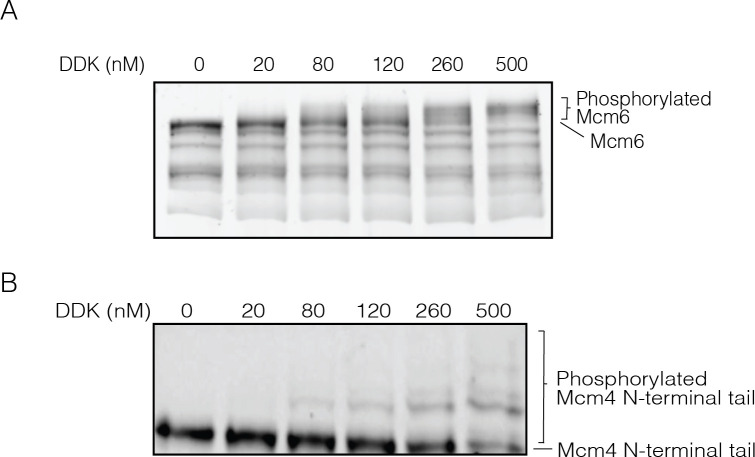
Higher Dbf4-dependent kinase (DDK) concentrations result in higher numbers of phosphorylation events on Mcm6 and Mcm4.(A) Phosphorylation of loaded wild-type Mcm2-7 with increasing concentrations of DDK. After loading onto DNA beads, Mcm2-7 complexes were phosphorylated with the indicated concentrations of DDK. Phosphorylated Mcm2-7 was separated on a 10% SuperSep Phos-tag gel and stained with Krypton Protein Stain to separate Mcm2-7 subunits with different numbers of phosphorylation sites. (B) The Mcm4 N-terminal tail fused to SNAP-tag protein was phosphorylated with increasing concentrations of DDK. The phosphorylated Mcm4 N-terminal tail was separated on a 10% SuperSep Phos-tag gel and stained with Krypton Protein Stain.